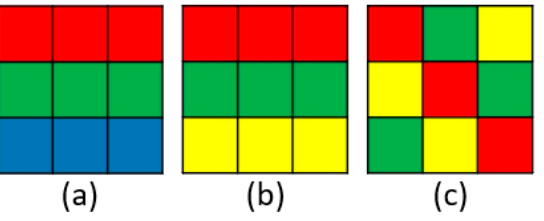
Figure 2. Examples of Shannon entropy of simulated data. ( a ) and ( b ) have different composition, but the same spatial distribution; ( b ) and ( c ) have the same composition but different spatial distri- butions.